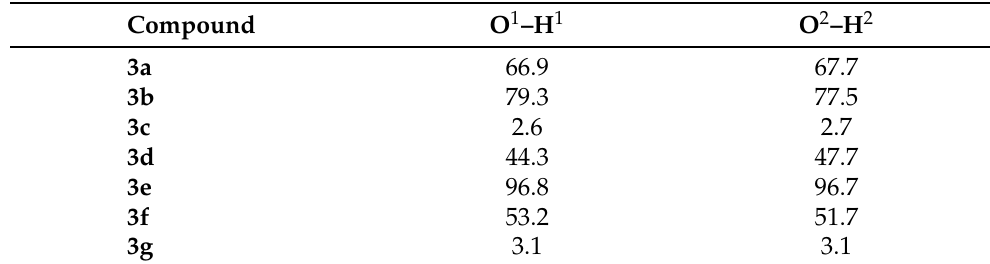
Table 4. Percentages of proton possession by the donor atoms in both hydrogen bridges of each investigated compound of group 3 —results of the CPMD